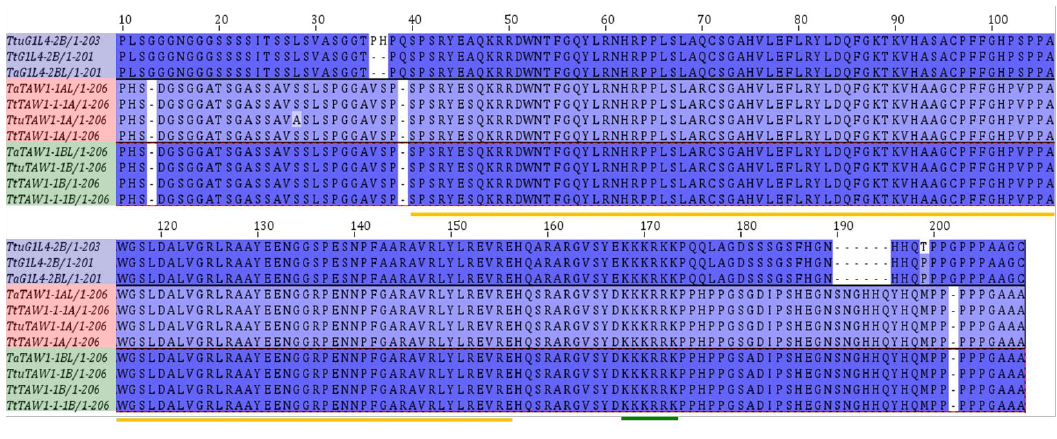
Figure 5. Analysis of the mutant ALOG proteins among wheat. The ALOG proteins were cloned from GAN-A631 (bh) and GAN-A1582 (nh) and their amino acid sequences were compared with those from the T. aestivum and T. turgidum ssp. Dicoccoides genomes. A conserved region and a nuclear localization signal are indicated with orange and green lines, respectively. GAN-A631 sequences: TtTAW1-1A and TtTAW1-1B . GAN-A1582 sequences: TtTAW1-1-1A and TtTAW1-1-1B .